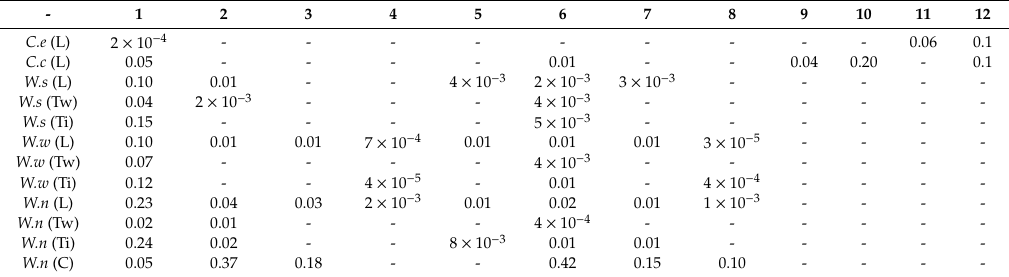
Table 1. Yields of isolates 1–12 in % ( g/g ). C.e— Callitris endlicheri , C.c— C. columellaris , W.s— Widdringtonia schwartzii , W.c— W. wallichii , W.n— W. nodiflora . (L)—Leaves, (Tw)—Twigs, (Ti)—